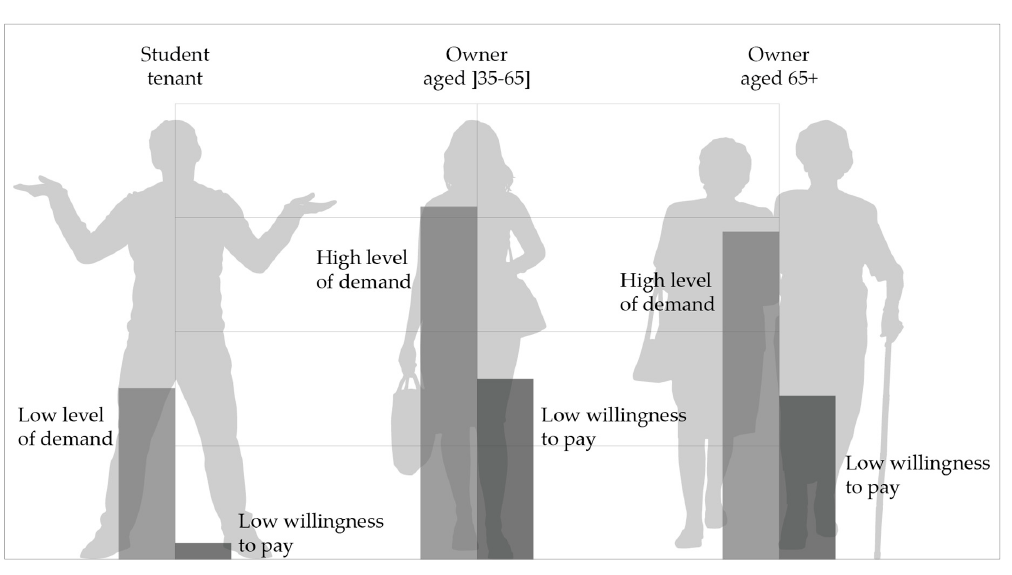
Figure 6. Significant occupant profiles.